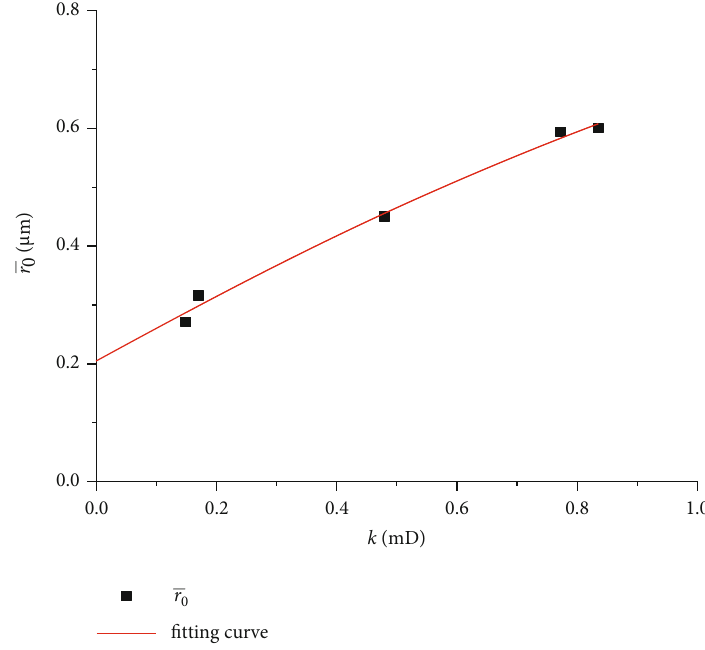
Figure 9: Relationship between average radius and